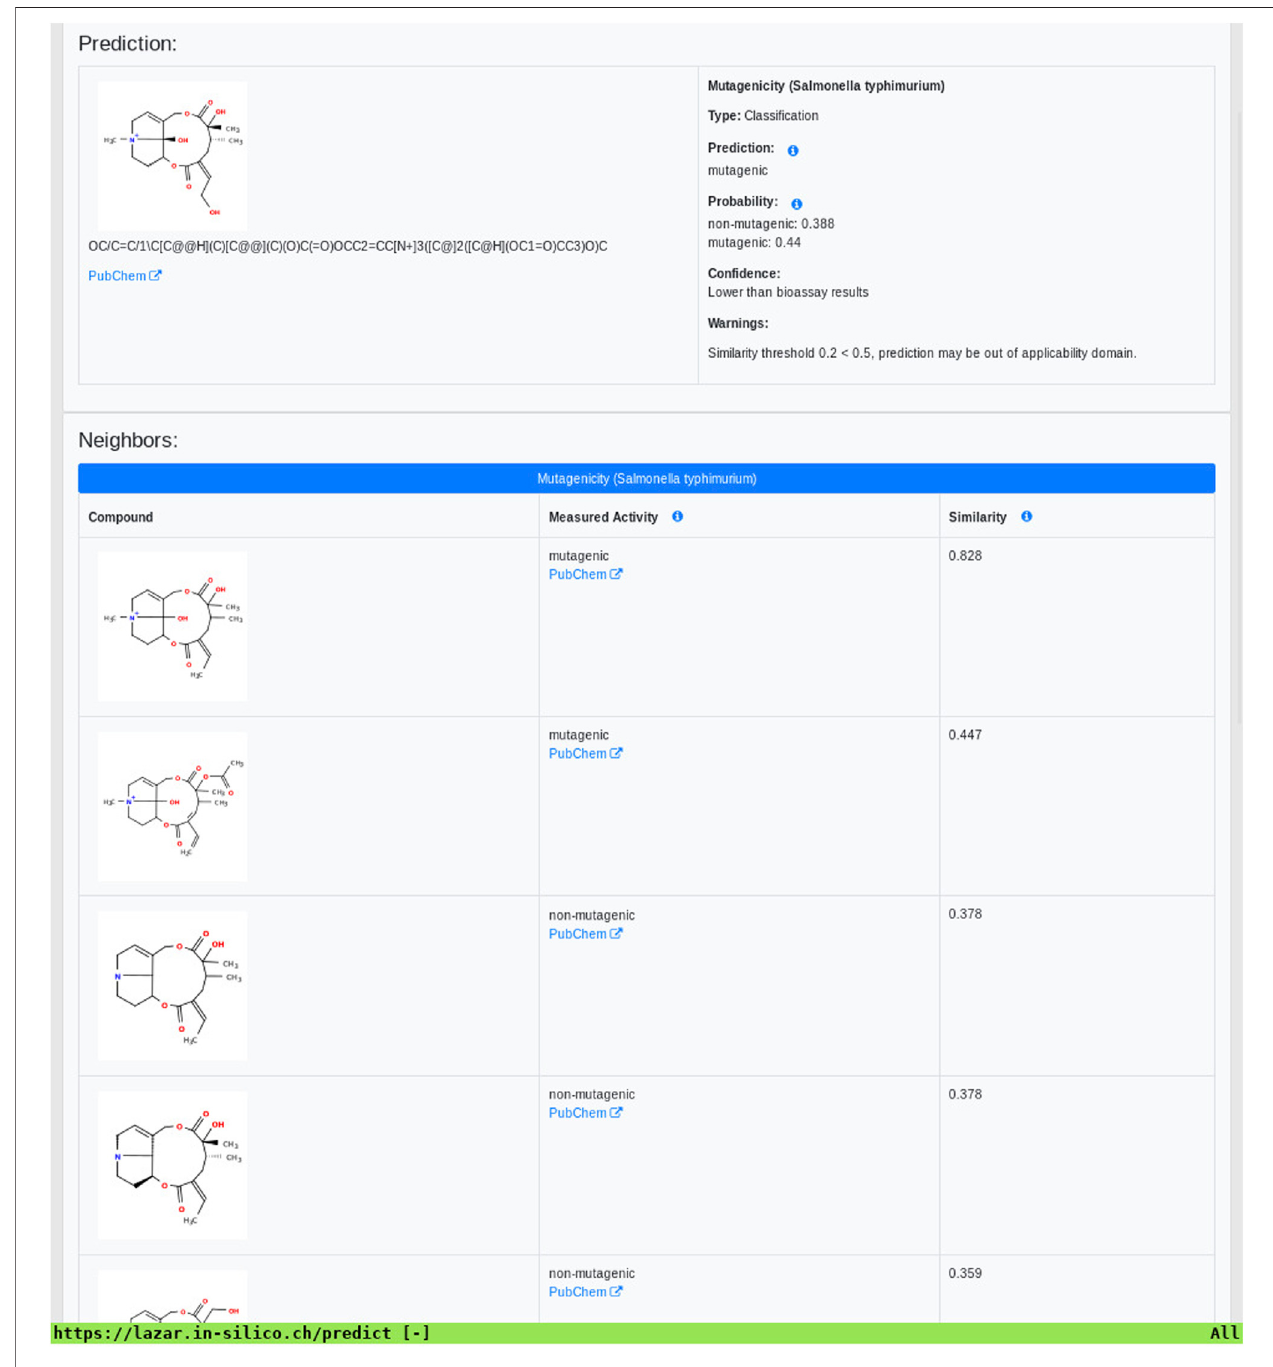
FIGURE 8 | Lazar screenshot of 12,21-Dihydroxy-4-methyl-4,8-secosenecinonan-8,11,16-trione mutagenicity prediction.